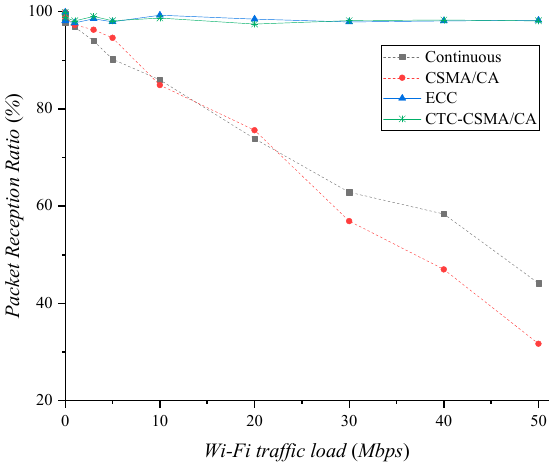
Figure 5. Packet reception ratio of Zigbee transmission according to Wi − Fi traffic load.